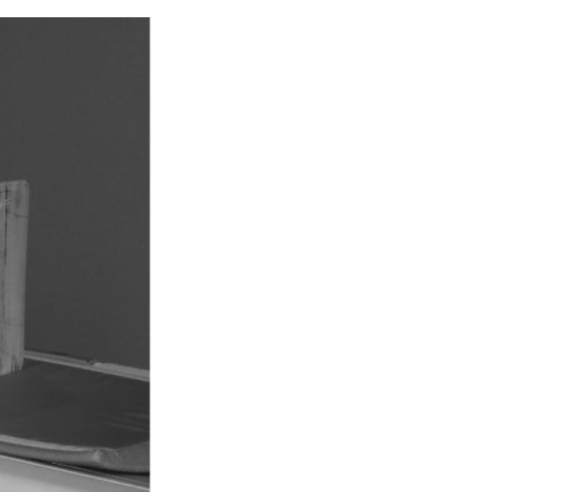
Figure 7. Quadrature surface coil. Reprinted by permission from Maril et al., Magn Reson Med 2006